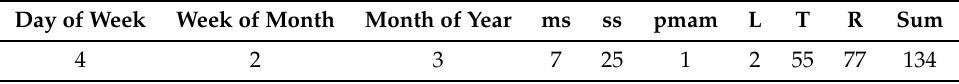
Table 2. A sample of data after the pre-processing step.